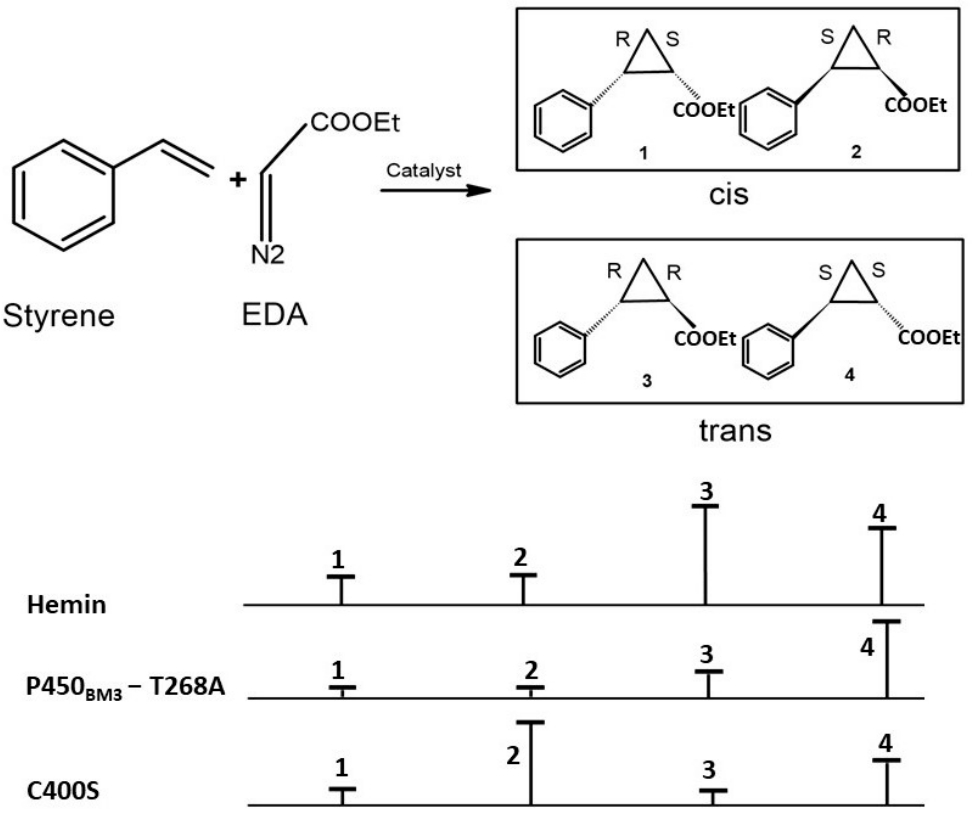
Figure 5. Cyclopropanation stereoselectivity of variants of P450 BM3 . The hemin and the variant T268A exhibited trans selectivity with a cis : trans ratio of 6:94 and 1:99, respectively. The C400S variant displays a strong preference for cis product formation.